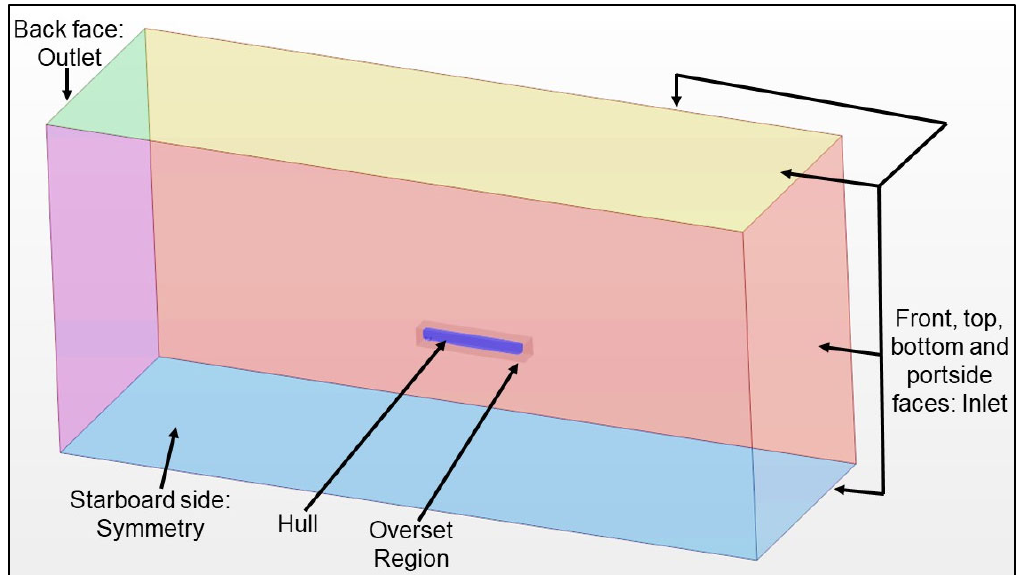
Figure 3. Boundary conditions in CFD simulations of the